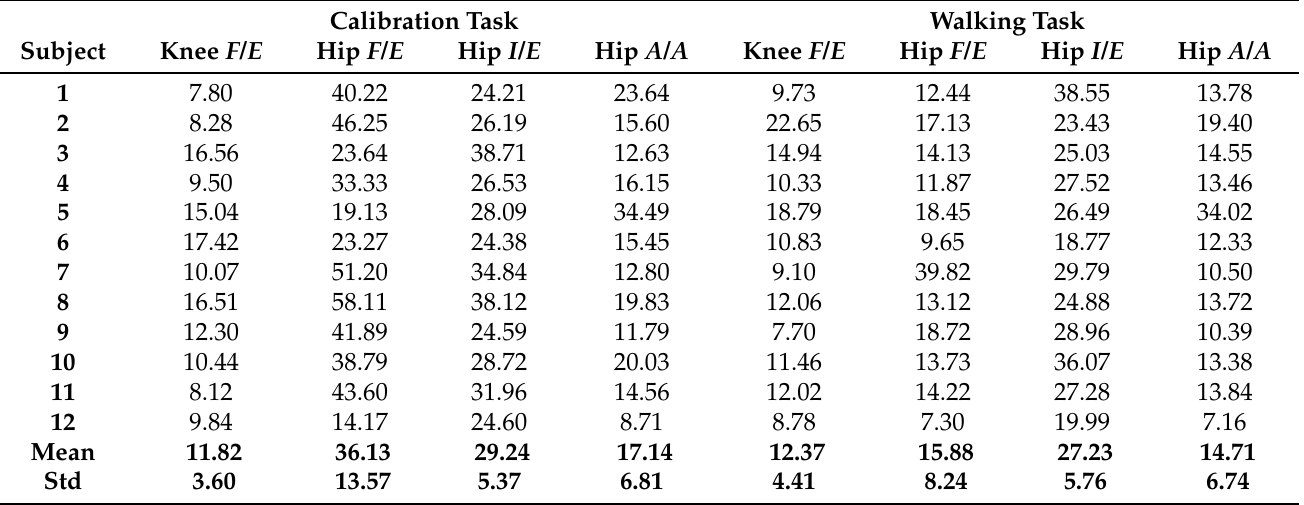
Table 3. Peak error (degrees) of relative IMU joint angles vs. mocap joint angles for both the calibration and walking tasks. F/E , I/E , and A/A refers to flexion/extension, internal/external rotation, and abduction/adduction of the joint, respectively. Values are the average value for the right and left